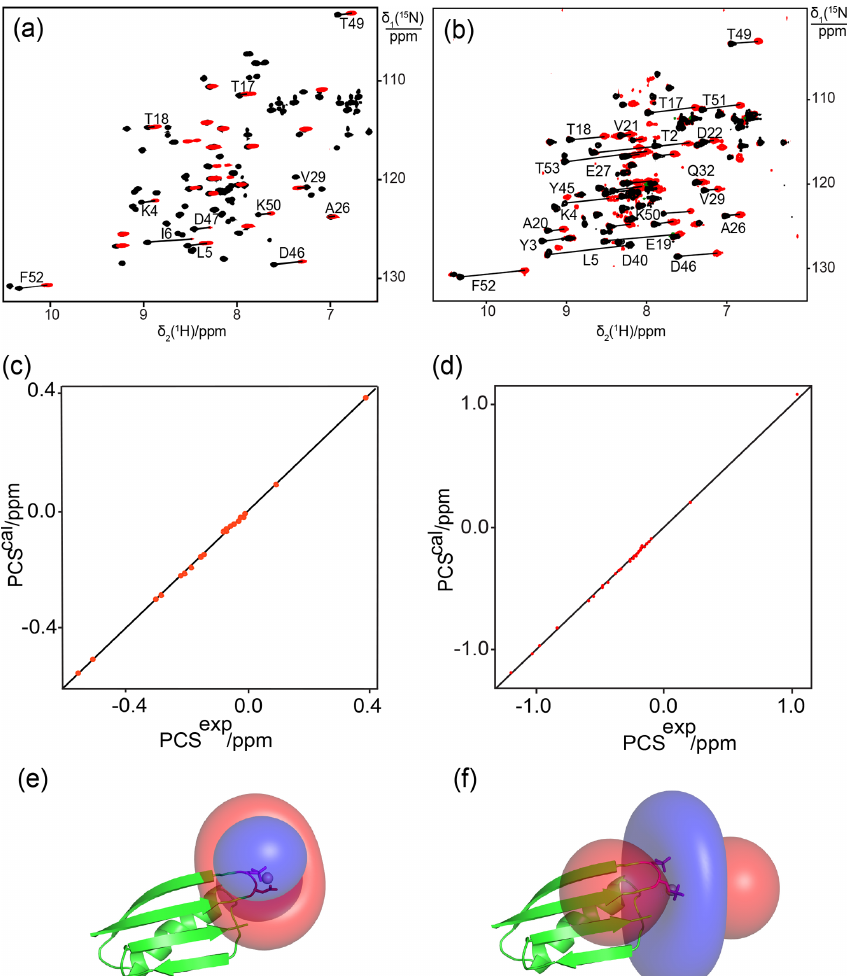
Figure 3. Close agreement between experimental and back-calculated PCSs of amide protons in the protein GB1 obtained with lanthanide- binding sites generated with one or two phosphoserine residues. (a) and (b) : superimposition of [ 15 N, 1 H]-HSQC spectra of 0.3mM solutions of GB1 K10D/T11Sep and GB1 K10Sep/T11Sep, respectively. The spectra were recorded in the presence of Tb 3 + (red) or Y 3 + (black). Lines connect cross-peaks belonging to the same residue in the paramagnetic and diamagnetic samples. (c) and (d) : correlation between back-calculated and experimental PCSs for GB1 K10D/T11Sep and GB1 K10Sep/T11Sep, respectively. (e) and (f) : location of the Tb 3 + ion on the GB1 mutants K10D/T11Sep and K10Sep/T11Sep, respectively, and PCS isosurfaces plotted on the structure of GB1. Blue and red isosurfaces indicate PCSs of ± 1ppm,